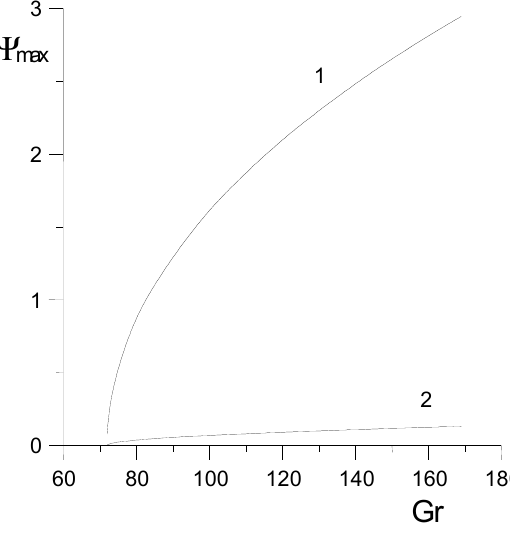
Figure 5. The intensity of the finite-wavelength (curve 1) and longwave (curve 2) regimes.